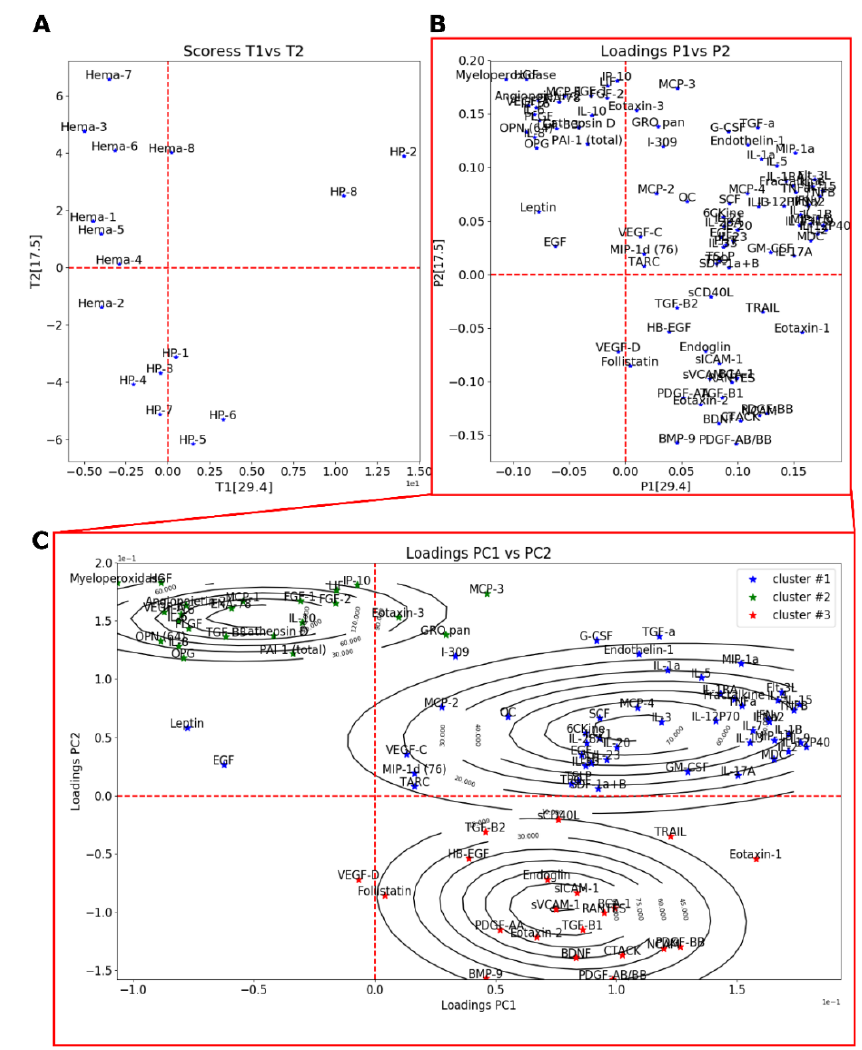
Figure 5 . PCA analysis of ELISA multiplex cytokine dosage showing the scores depicted as individuals ( A ) and the loadings depicted as the cytokines ( B ) of PC1 (29.4% variance explained) and PC2 (17.5% variance explained). ( C ) Results of clustering of loadings on PC1 and PC2 using Expectation-Maximization Clustering Algorithm showing the loadings (stars) and the 2D estimated distribution (contour lines).